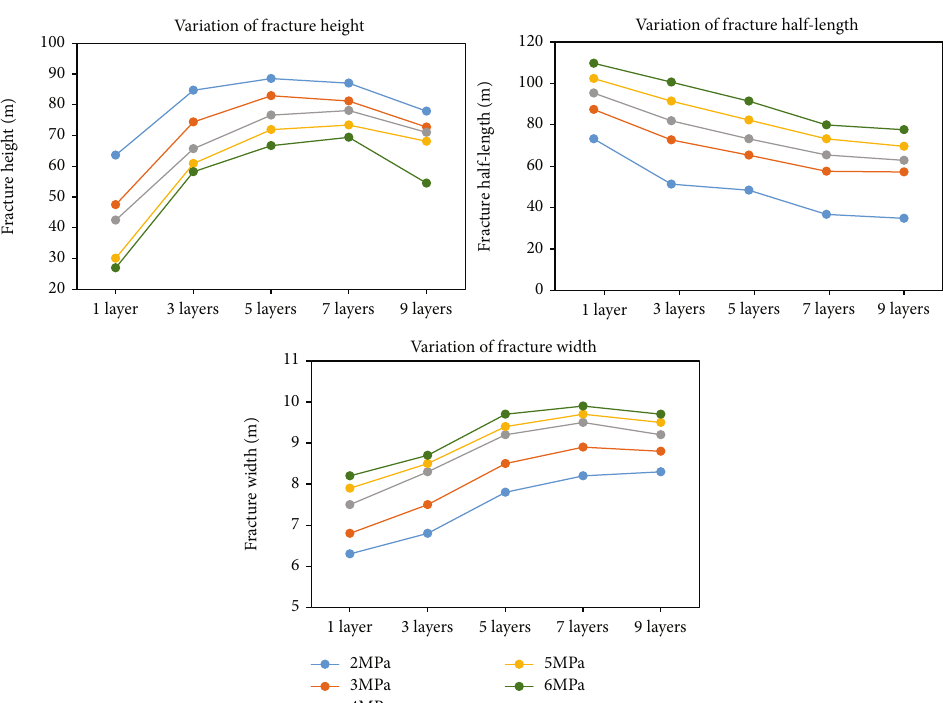
Figure 9: Variation of hydraulic fracture shape with the geostress and layer